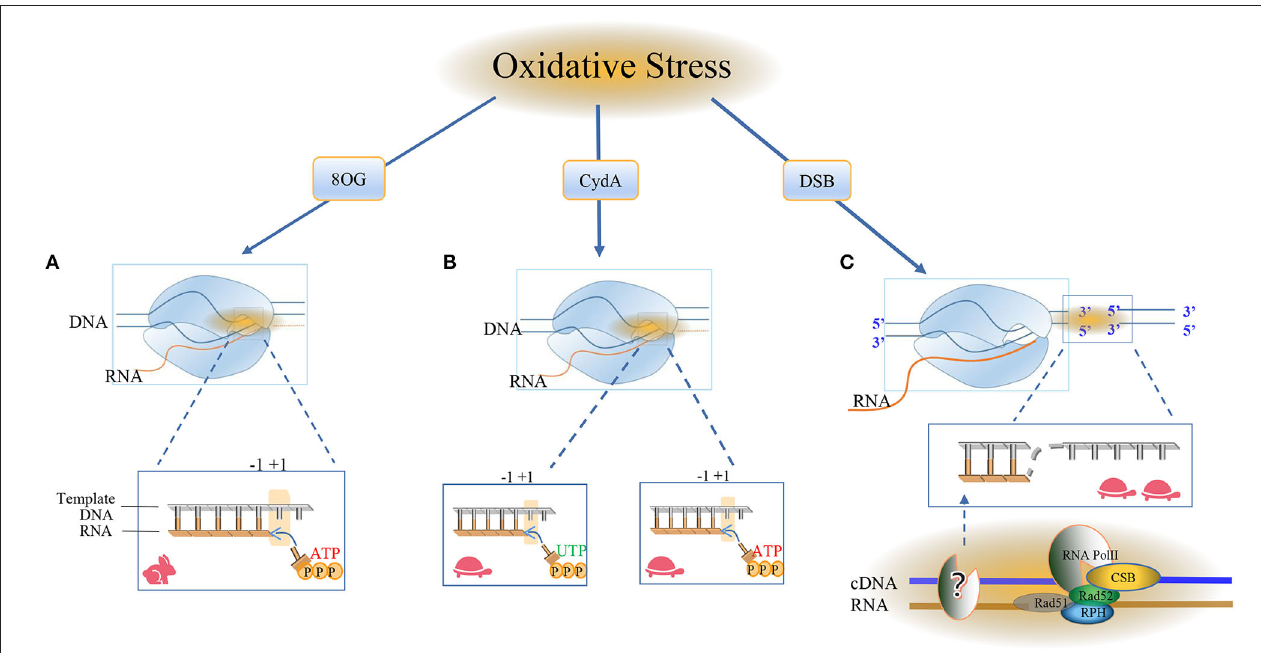
FIGURE 4 | RNA Pol II bypasses the oxidative damage nucleotide addition cycle. The damage caused by oxidation here includes 8oxoG, CydA, and DSBs, and it is obvious that different cell types use different repair pathways at different rates. (A) Most of the oxidative modifications on bases can be bypassed by RNA Pol II. RNA Pol II bypasses the repair mechanism of oxidative damage and incorporates nucleotides into RNA. The RNA and Pol II form a ternary complex, in which the template DNA and the newly-born RNA form the core transcription bubble of Pol II. During the transcript extension process, RNA synthesis and the forward movement of Pol II will pass through the “Brown ratchet” coupling of translocation mechanisms. OG is one of the markers of oxidative stress. Pol II turns on the rapid transcription bypass, and DNA glycosylase triggers the release of specific DNA enzymes to identify and ablate damage and is used by BER in neuronal cells. Repair, the formation of ATP ready to pair with the base in the active site, the translocation mechanism creates a new RNA 3’end in the free + 1 position in the active template, and RNA Pol II occupies the polymerase active site. (B) CydA is the damage in CydU that can cause Pol II transcription stagnation in human cells, opening a slow damage bypass, and polymerase is added to the UTP downstream of the CydA lesion and the DNA is pushed into the active position of RNA polymerase. Incorrectly adding AMP residue on the opposite side of the base of the downstream template, Pol II will translocate at the + 1 position and slow down the subsequent elongation. (C) The surge of oxidative DNA damage puts too much pressure on the BER system and leads to DSB. Actively transcribed genes use transcription-coupled homologous recombination (TC-HR). RNA Pol II stagnates in the lesion, and the DNA-RNA hybrid structure recruits CSB. Then, the interaction between RNA Pol II and CSB initiates TC-HR and provides a scaffold for HR factors, such as Rad 52 and Rad 51C, which directly interact with CSB. There is a DNA polymerase upstream of the lesion site, which reverse-transcribes the template strand. The RNA polymerase II (Pol) in thermodynamics occupies the Pol active site. In the post-translocation